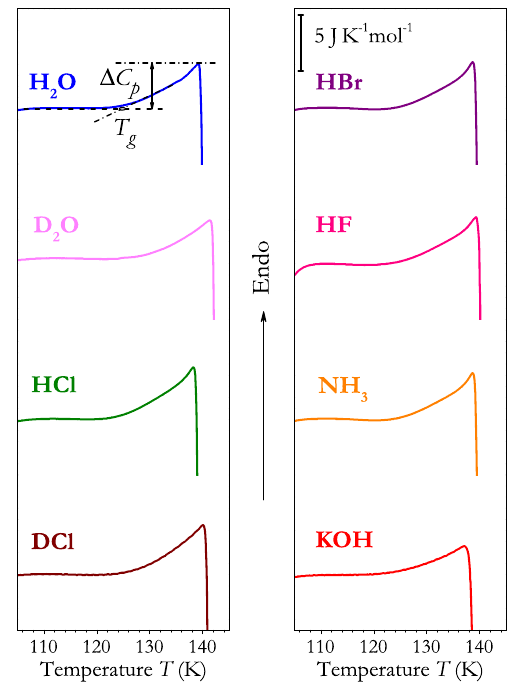
FIG. 7. Calorimetric scans from quench-recovered eHDA samples heated at ambient pressure at a rate of 50 K min − 1 . This figure represents a magnification of the low-temperature part from Fig. 3. A representation of the evaluation method of Δ c and T is shown here by dashed g